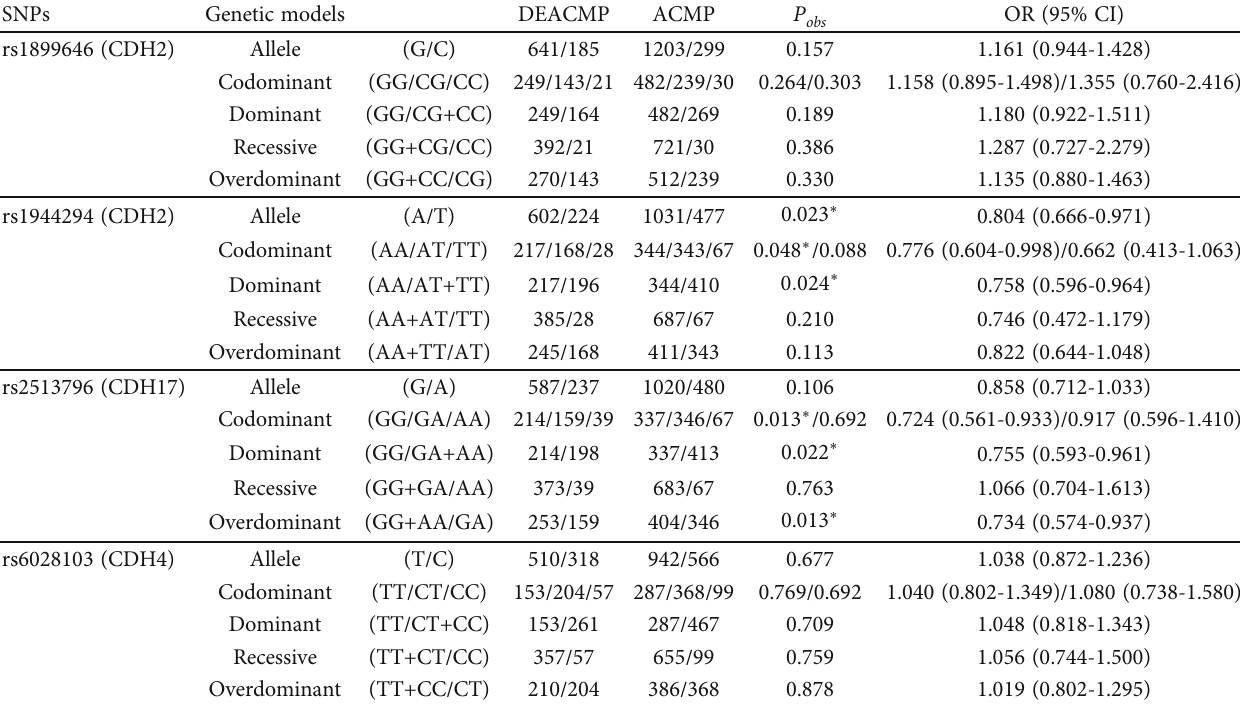
Table 4: Association analysis of cadherin polymorphisms under di ff erent genetic models and DEACMP risk.